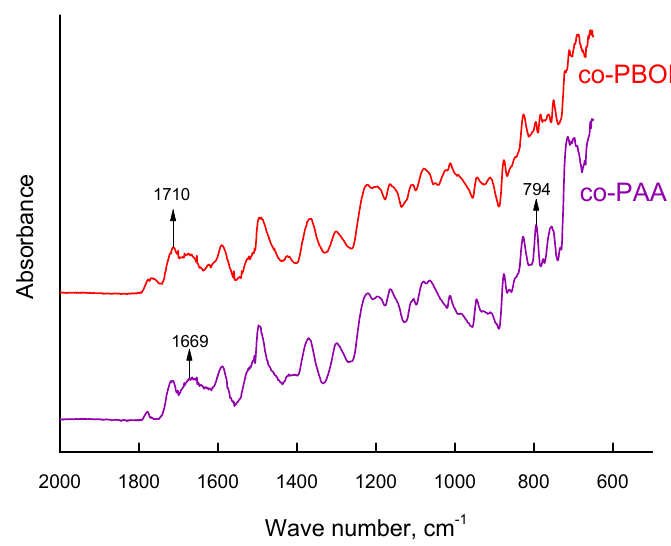
Figure 3. ATR-FTIR spectra of co-PAA and co-PBOI membranes.